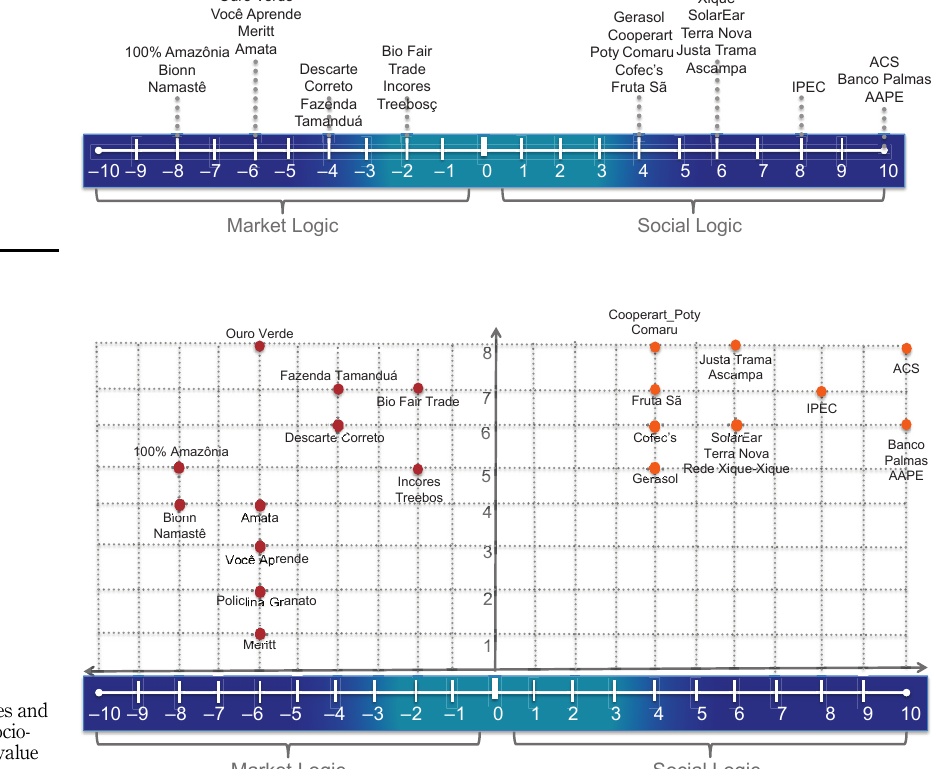
Figure 4. Social businesses and generation of socio- environmental